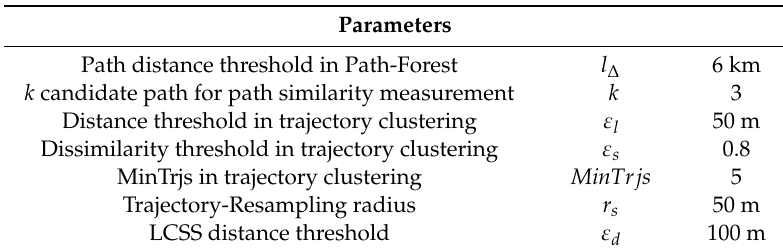
Table 4. Configuration of CMM.